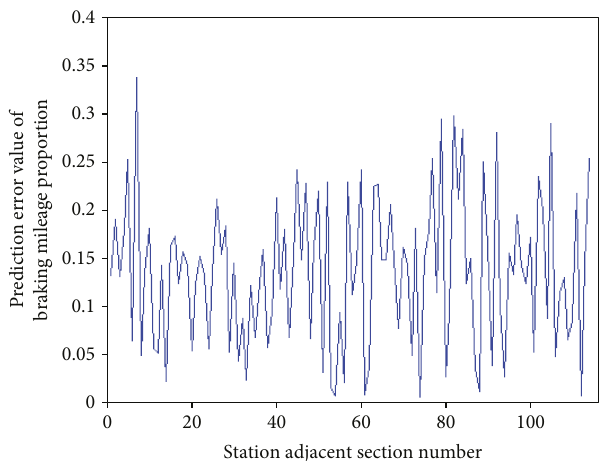
Figure 7: In fl uencing factors ’ prediction error (braking mileage proportion).